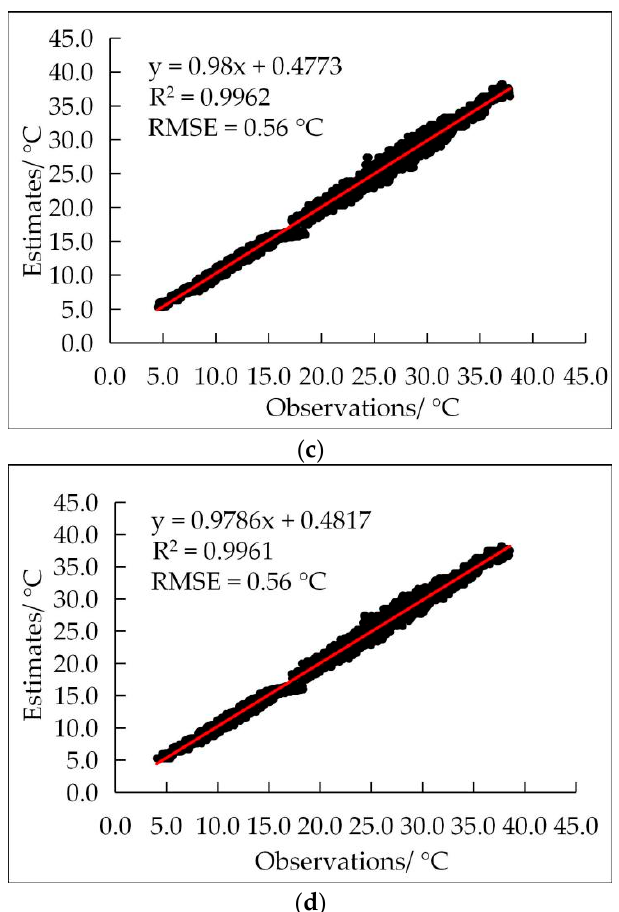
Figure A2. The linear fitting results of the observed and simulated values are reduced by 4 temper- ature sensors. ( a ) Reduced column B; ( b ) Reduced column C; ( c ) Reduced column D; ( d ) Reduced column E.